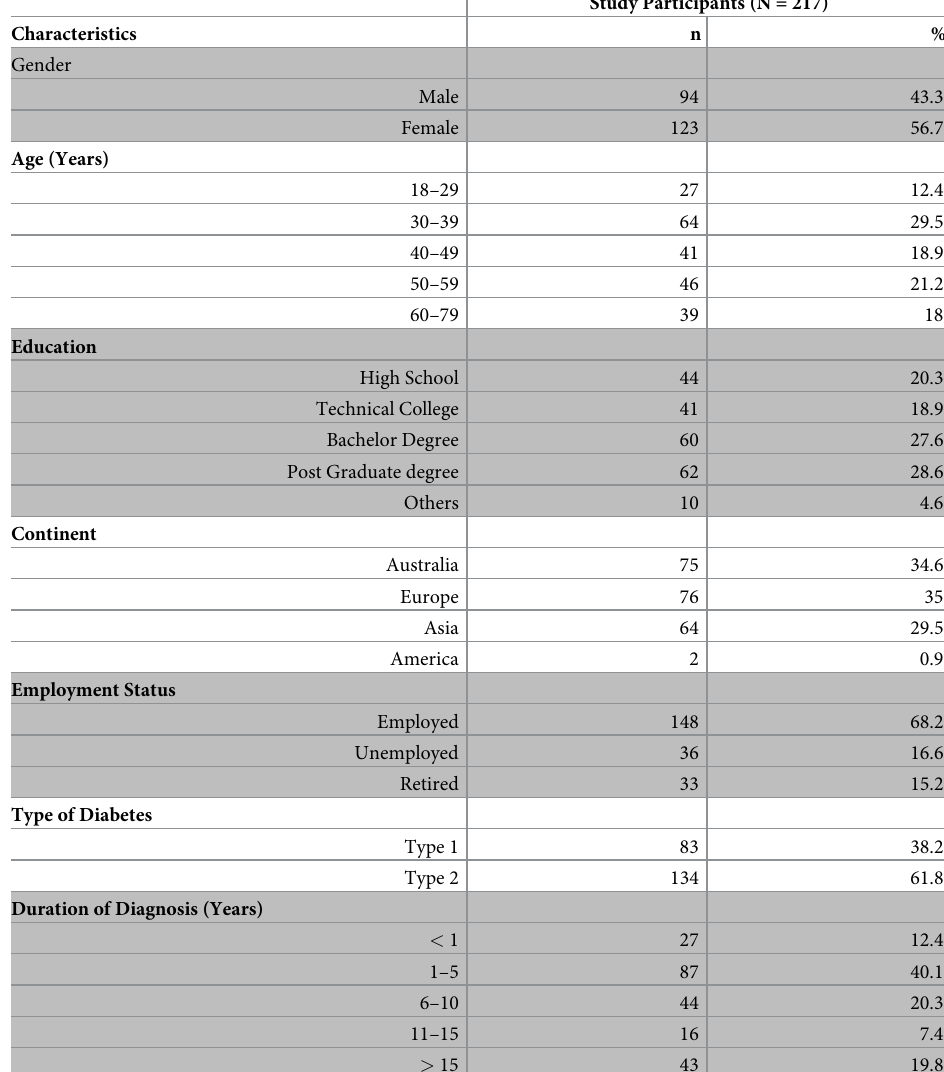
Table 1. Demographic and health characteristics of survey